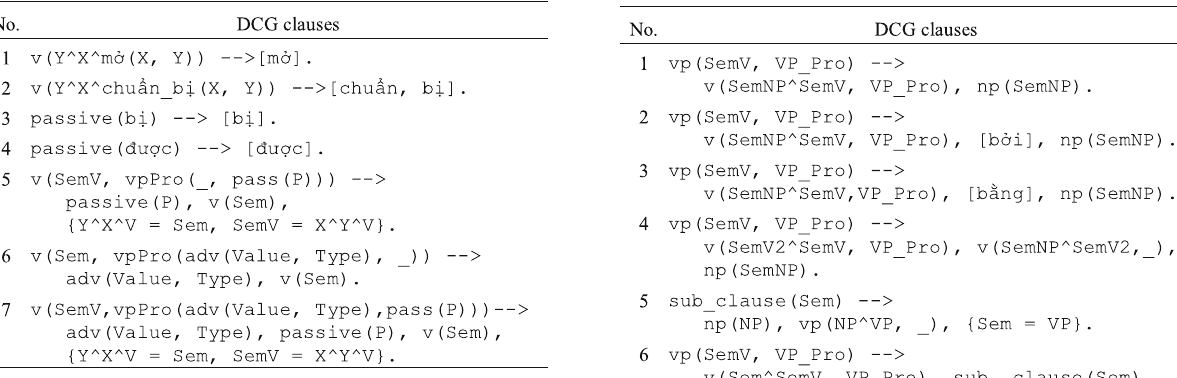
Table 13 DCG clauses are used to compute the semantics for verb